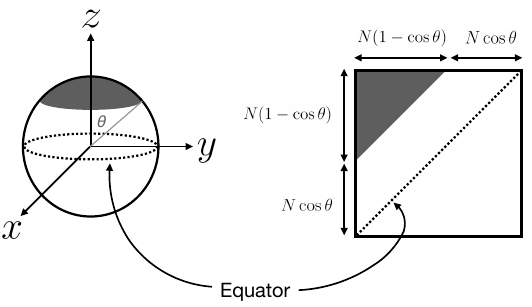
Figure 3 . Partitioning of fuzzy sphere based on latitude (left) and the corresponding partitioning of matrix degrees of freedom (right) [54–56]. Specific gauge choice (4.1) is